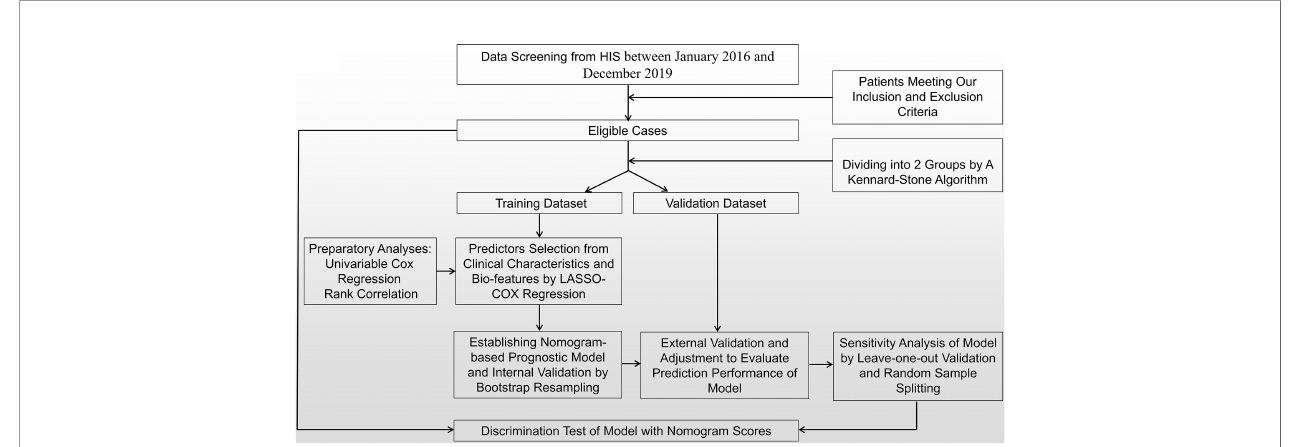
FIGURE 1 | Flowchart of study pro fi